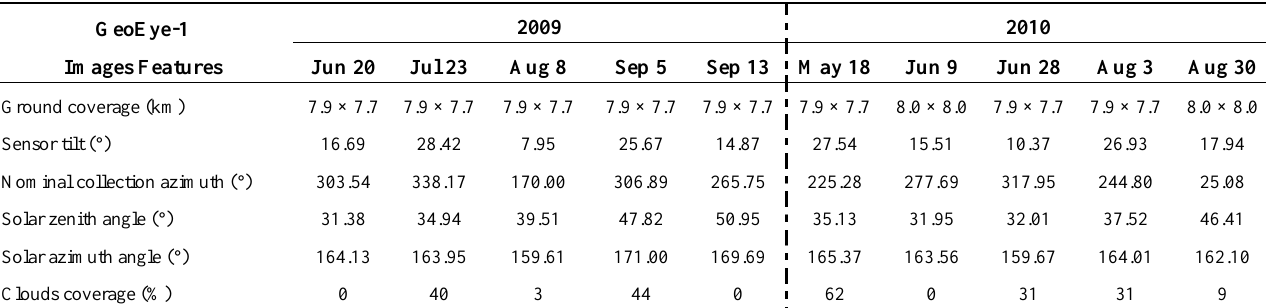
Table 1. Features of the acquired GeoEye-1